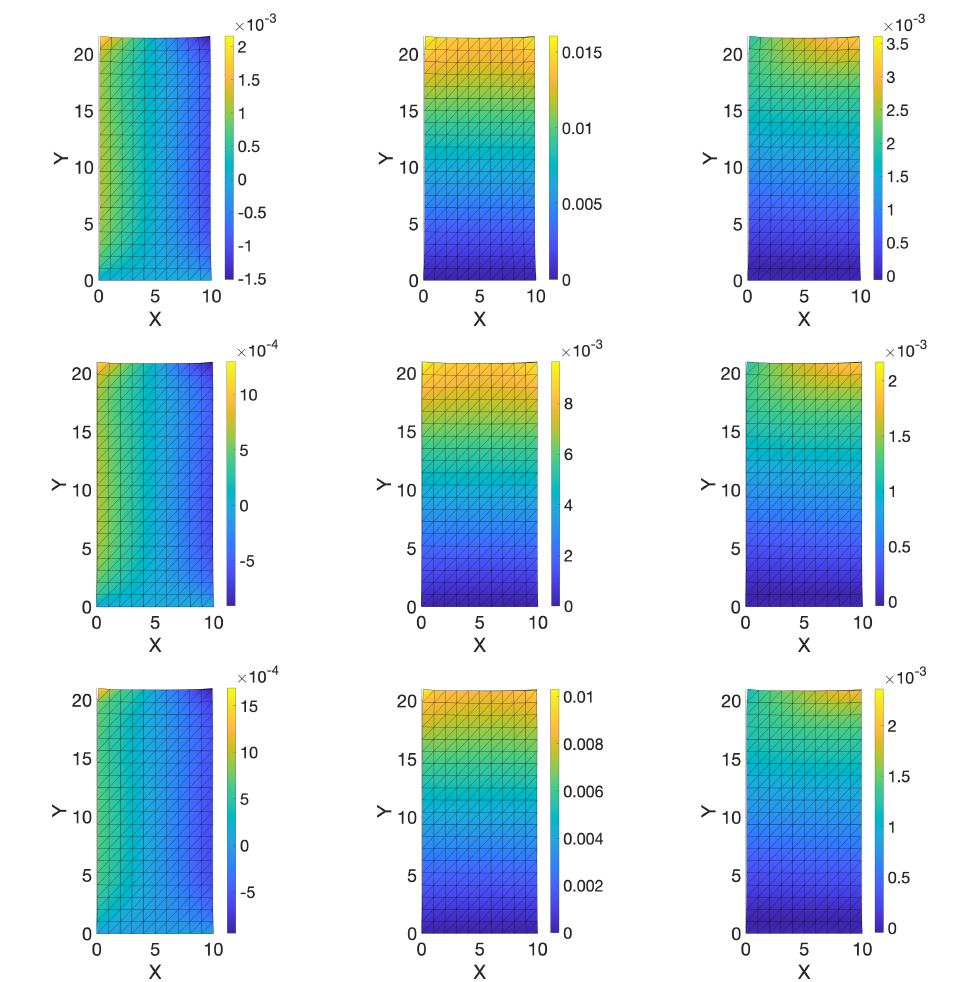
Figure 19. Top view of the x ( left ), y ( center ) and z ( right ) components of the displacement field associated to the nominal solution ( top ), the reference solution ( middle ) and the enriched model solution ( bottom